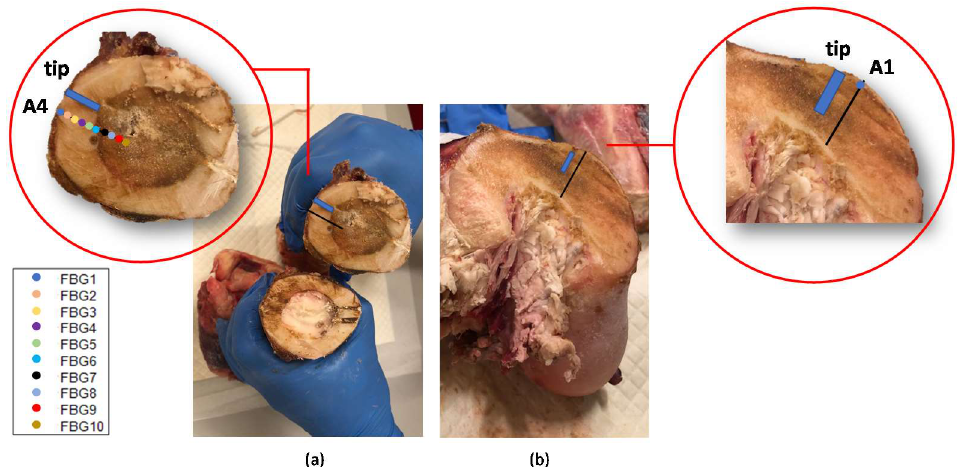
Figure 12. Bones dissections after the MWA treatments. The blue rectangle indicates the antenna tip position in the bone section and the colored markers in the insets indicate the FBGs located in same bone section measuring temperatures higher than 60 ◦ C. In ( a ), a diaphyseal section: in correspondence of the MW antenna site (where the bone marrow became brown as was damaged by the heat) and far from the antenna (where the bone marrow shows its natural color). In ( b ), the section in correspondence with the trochanter.